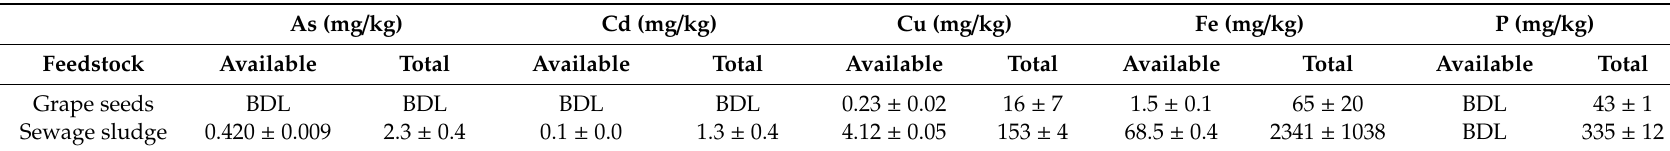
Table 2. Diethylenetriaminepentaacetic acid ( DTPA) / CaCl 2 extractable and total concentrations of potentially toxic elements and P in initial feedstocks (mg / kg) (averaged value ± standard error; n = 2 or